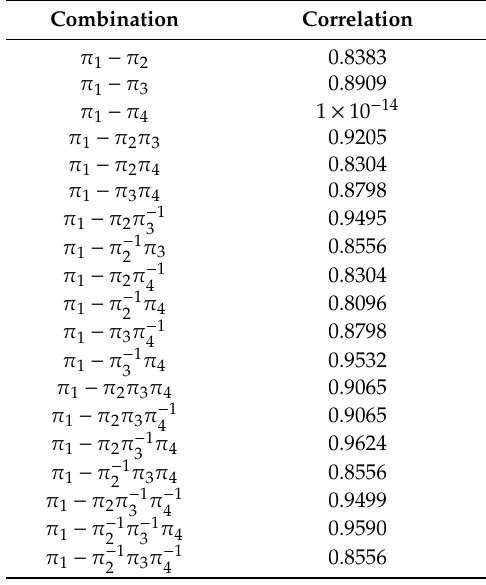
Table 3. Dimensionless combinations in order to improve correlation.